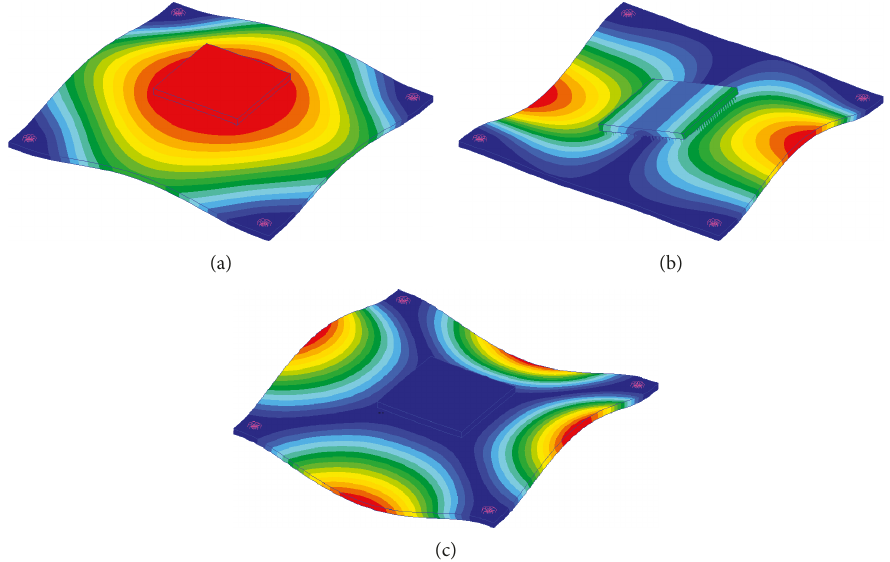
Figure 13: Modal analysis results for PCB ((a) 1st mode: 370 Hz, (b) 2nd Mode: 819.09Hz, (c) 3rd Mode: 1180.1